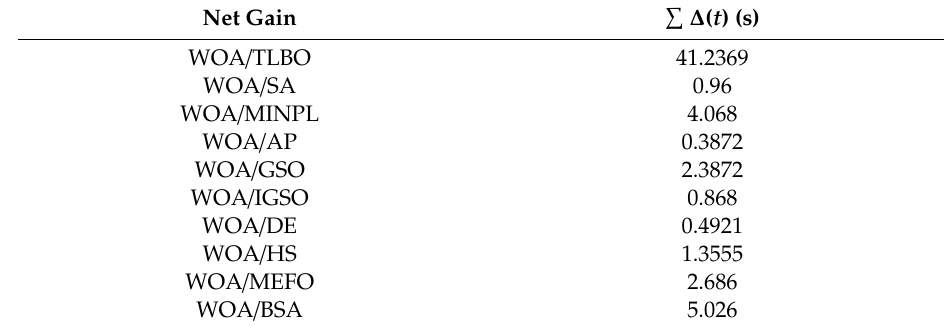
Table 15. Comparison of total net gain in time achieved by the WOA with the methods used in the literature for the IEEE 15-bus